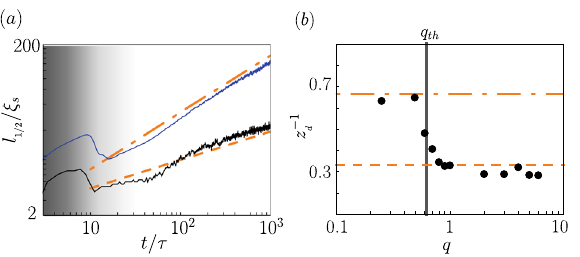
0 exhibits two different scaling laws depending on the value of q . Here, Figure 4. ( a ) l 1 / 2 /ξ s versus t /τ for M = 0.5 (blue solid line) and q 1 (black solid line). The scaling t 2 / 3 is marked by the orange dot-dashed line, q ∼ = = t 1 / 3 by the orange dashed line. Initial times of domains nucleation are shaded. ( b ) The inverse of the while ∼ 1 t 1 / z d to the numerical data. dynamical exponent z − d versus q is extracted at long times by fitting the function ∼ 0.62 . The vertical thick gray line shows estimated values of the threshold point q th =